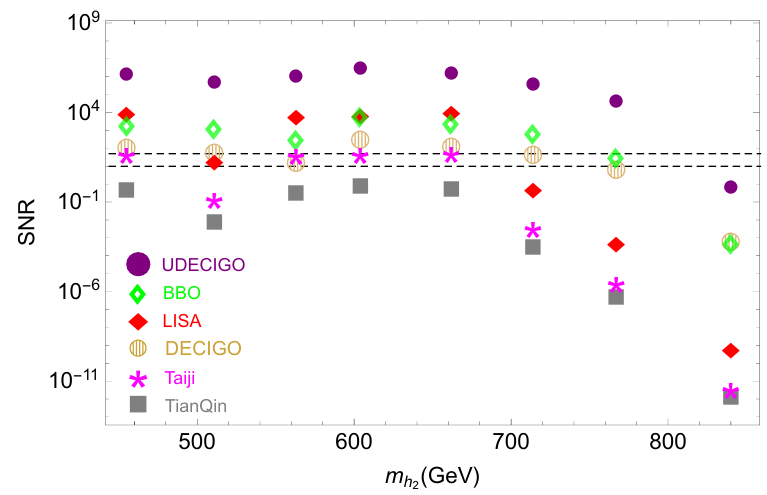
Figure 3 . The SNR of the gravitational wave signals versus m h for the benchmarks shown in 2 table 1 for proposed space-based gravitational wave detectors. The two horizontal dashed lines are suggested thresholds for detection: SNR = 10 and SNR = 50, depending on detector con(cid:12)gurations. where the peak frequency f corresponding to MHD is given turb